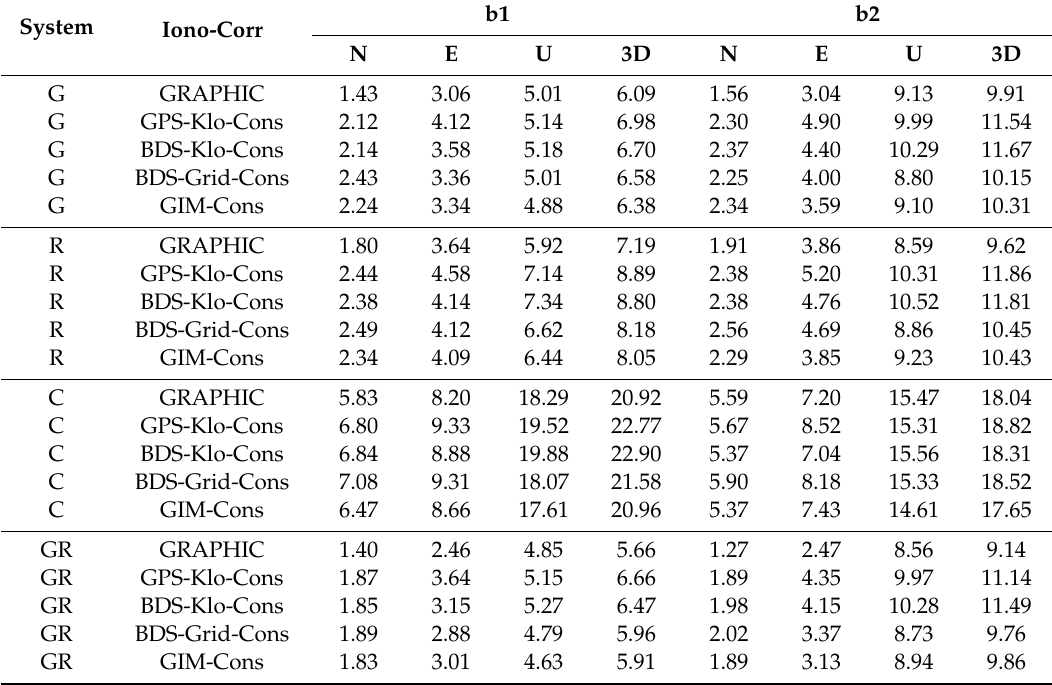
Figure 6. Average convergence time of SF-PPP with different schemes for GPS-only, GLONASS-only, BDS-only, GPS + GLONASS, GPS + BDS and GPS + GLONASS + BDS solutions using datasets at 10 stations over one month. Table 3. RMS of SF-PPP with the GRAPHIC approach, GPS-Klo-, BDS-Klo-, BDS-Grid-, and GIM- constrained approaches (unit: